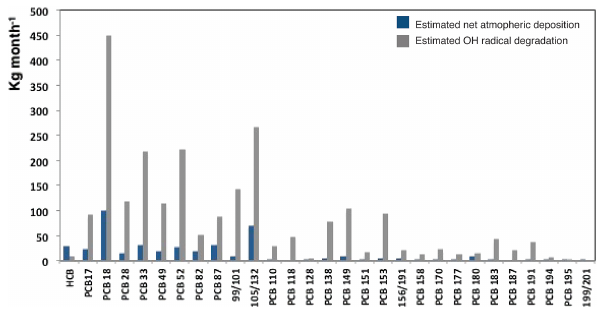
Figure 6. Comparison of losses of atmospheric PCBs and HCB due to atmospheric deposition and degradation by reaction with OH radicals during the summer. Fluxes are given as integrated for the whole Mediterranean